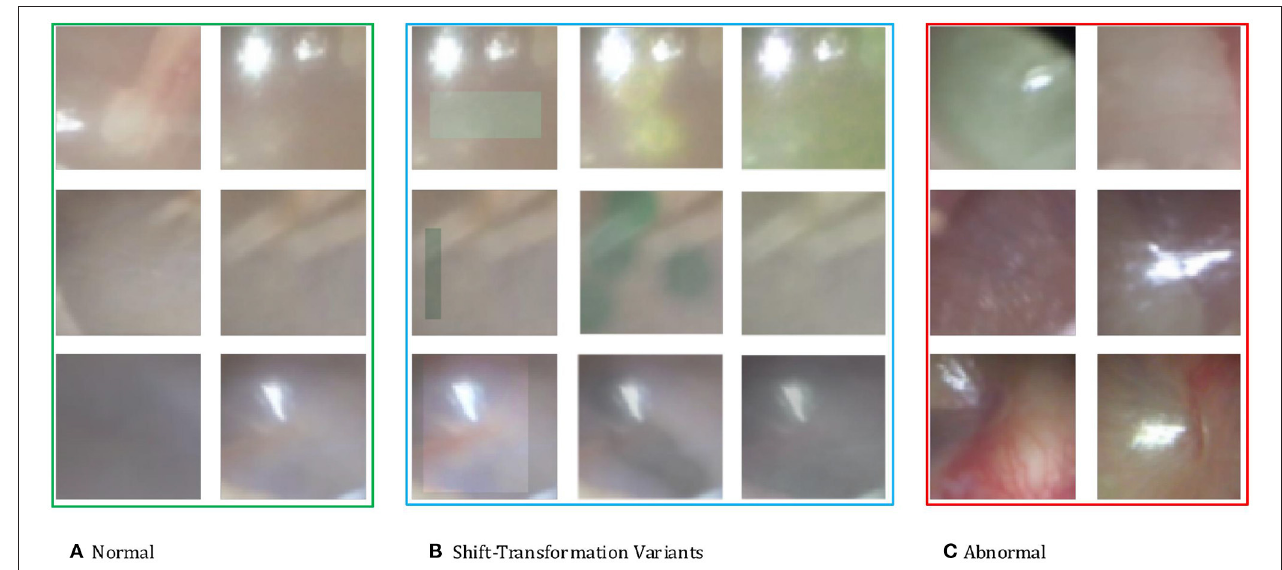
FIGURE 3 | (A) Normal eardrum region examples. (B) Shift-transformation variants applied to the second normal example of each row. From left to right: color-jitter-random-cut (CJ-RC), color-jitter-random-region (CJ-RR), color-jitter-whole-frame (CJ-WF). (C) Abnormal eardrum region examples.